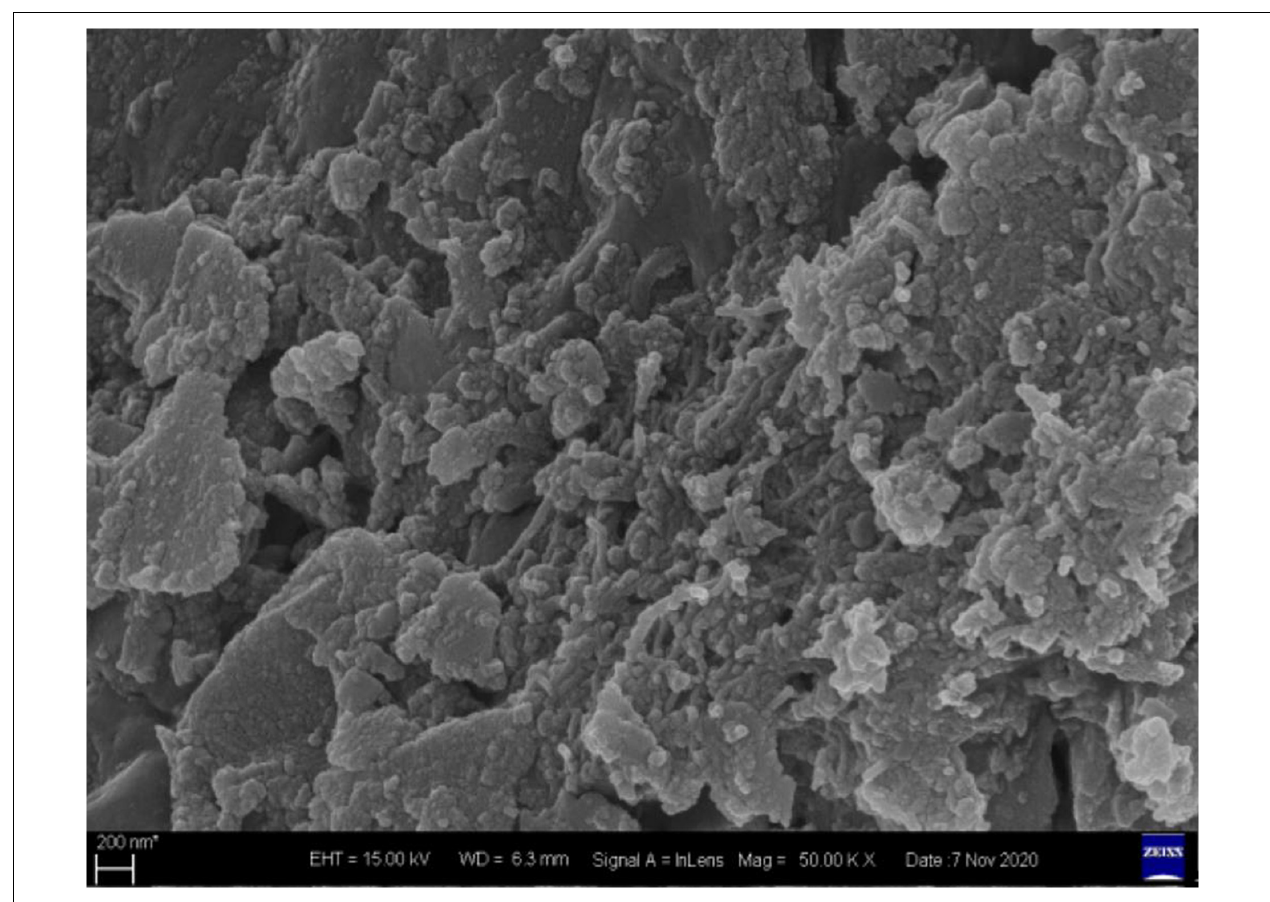
FIGURE 6 | SEM image of the Al 2 O 3 carrier-adopted MWCNTs.